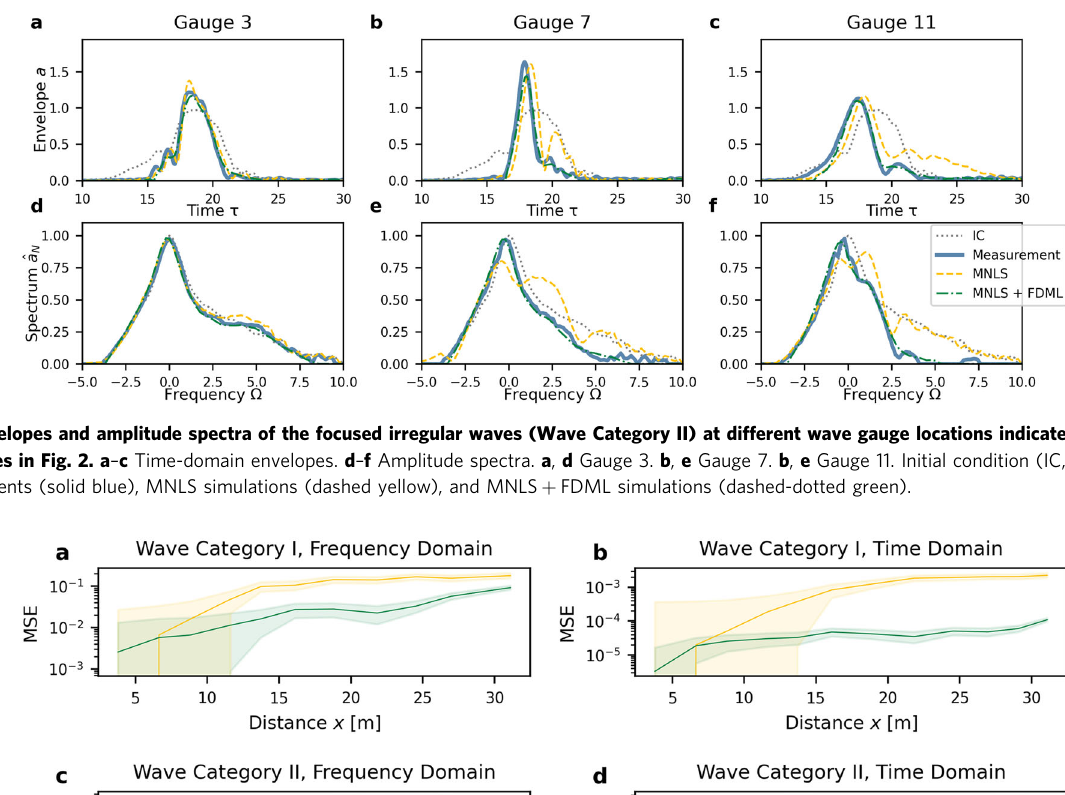
Fig. 3 Evolution of summary parameters of the focused irregular waves (Wave Category II) shown in Figs. 2 and 4. a Evolution of the norm N / N 0 b Evolution of the mean frequency Ω c . Note that Ω = 0 corresponds to the central peak of the initial spectrum, which is lower than Ω c for the initial k condition. c Evolution of the characteristic steepness η 0 . max